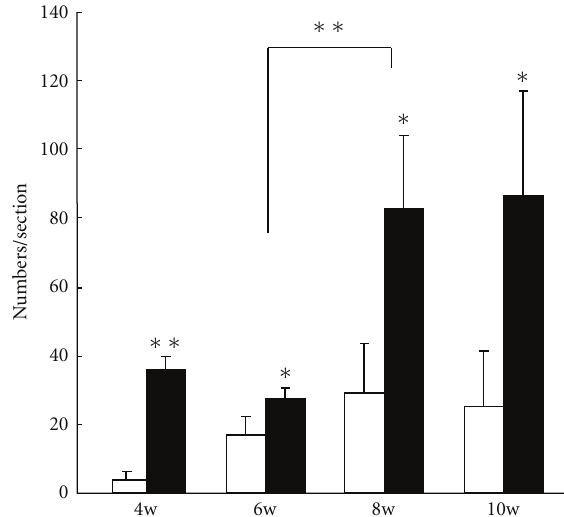
Figure 5: Density of lymphatic vessels (LVD) in tumors. The LVD in BJMC3879 tumors (black bars) is always significantly higher than that of BJMC338 tumors (white bars) ( ∗ P < 0 . 01, ∗∗ P < 0 . 001). hyaluronan receptor-1 (LYVE-1) (rabbit polyclonal, Acris Antibodies GmbH, Hiddenhausen, Germany). VEGF-C (Santa Cruz) was labeled on tumor sections, and activated macrophages were demonstrated by CD68 antibody (rat anti-mouse CD68, AbD Serotec, Oxford,